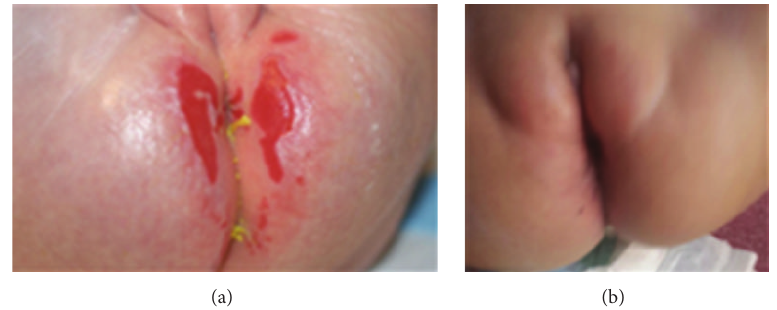
Figure 3: Perianal disease in the patient ((a) before HSCT, (b) after